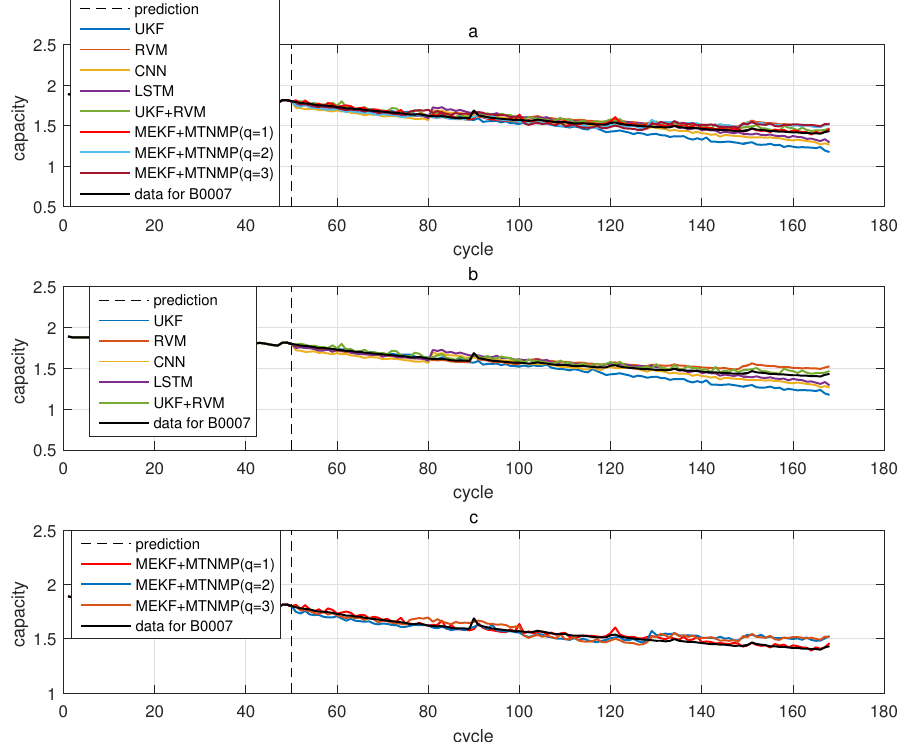
Figure 12. The simulation diagram of B0007 predicted from the 50th time. ( a ) is the experimental diagram of all methods, ( b ) is other methods used for comparison in ( a , c ) is the method proposed in this paper in ( a